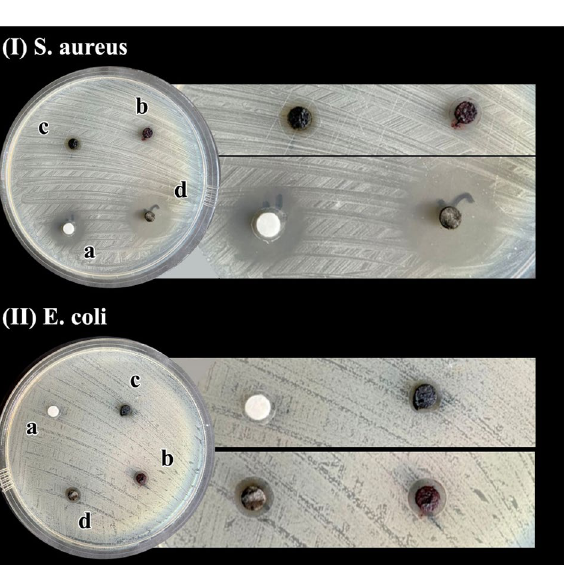
Figure 9. Recyclability of the agar supported ZnS/CuFe 2 O 4 hybrid catalyst in the synthesis of 5b .